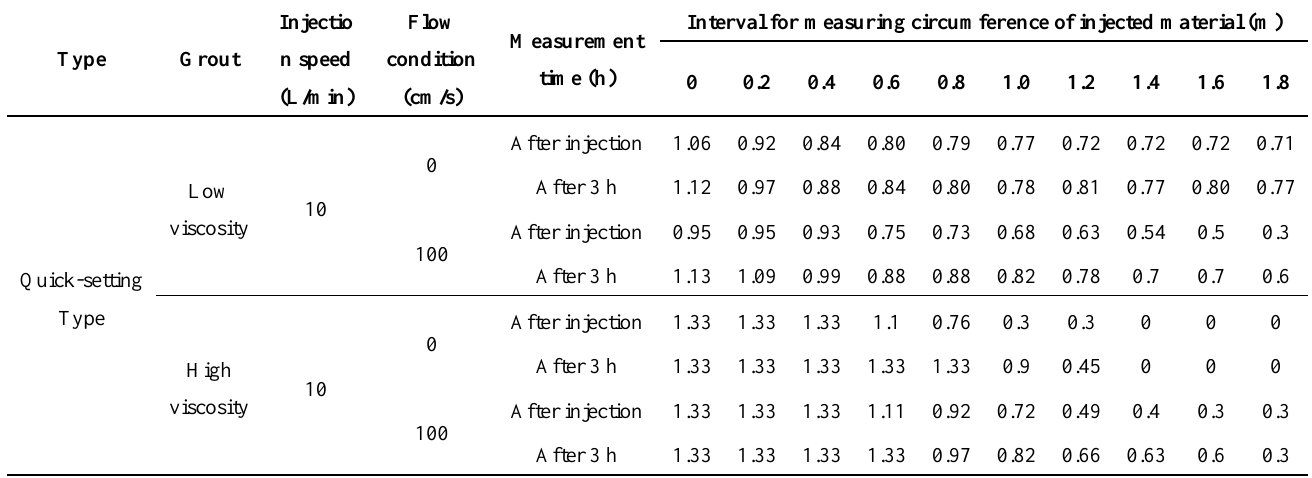
Table 3. Measured length for quick-setting type